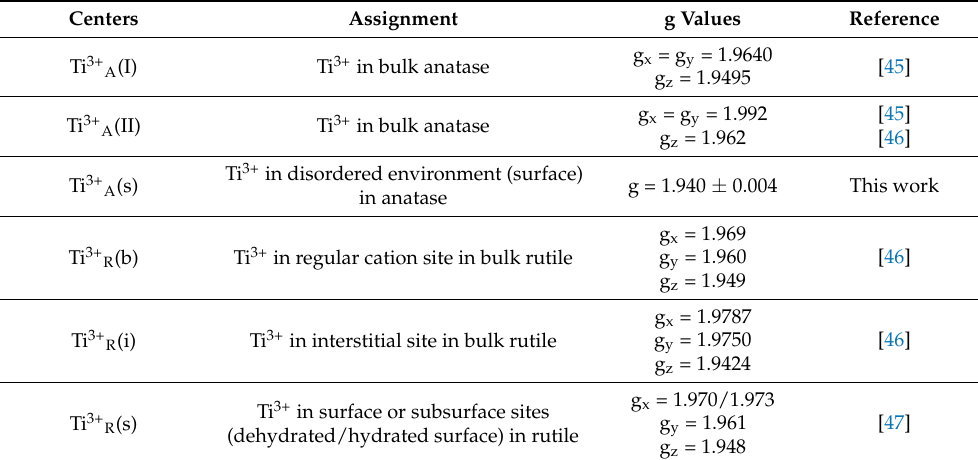
Figure 6. Experimental (solid black line) spectra of the T400W ( a ) and T400B ( b ) samples at 120 K. The simulated spectra (red dotted line) are the sums of the calculated spectra of the various paramagnetic centers represented below. The background resonator Mn 2+ spectrum (navy blue dashed line) was included for accuracy. The amplitudes of the Ti 3+ A (II) ( a ) and A, D ( b ) spectra were multiplied with the factors from the figure for better observation. Table 2. EPR parameters of the Ti 3+ centers in anatase and